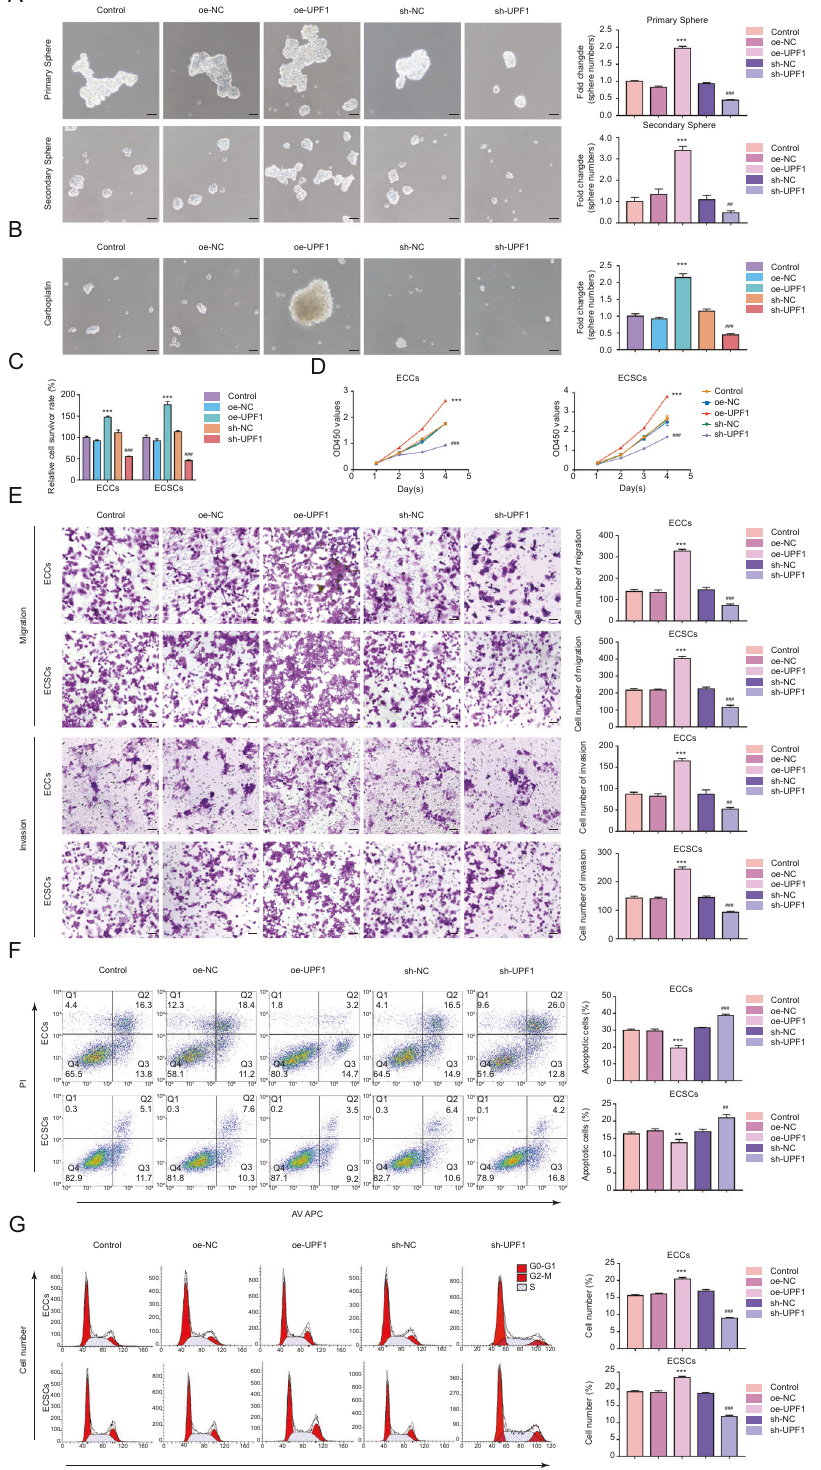
Fig. 2 UPF1 is required to maintain the ECSC phenotype. A Effects of UPF1 on self-renewal capacity assessed using serial sphere formation assay. B Effects of UPF1 on carboplatin resistance assessed using the sphere formation assay. C Effects of UPF1 on carboplatin resistance assessed by the CCK8 assay. D Effects of UPF1 on proliferation assessed by the CCK8 assay. E Effects of UPF1 on migration and invasion assessed using the Transwell assay. F Effects of UPF1 on apoptosis assessed using fl ow cytometry analysis. G Effects of UPF1 on cell cycle progression assessed using fl ow cytometry analysis. Data are presented as the means ± SEM ( n = 3, each group), ** P < 0.01, *** P < 0.001 vs. oe- NC group, ## P < 0.01, ### P < 0.001 vs. sh-NC group. Scale bars, 50 μ m.